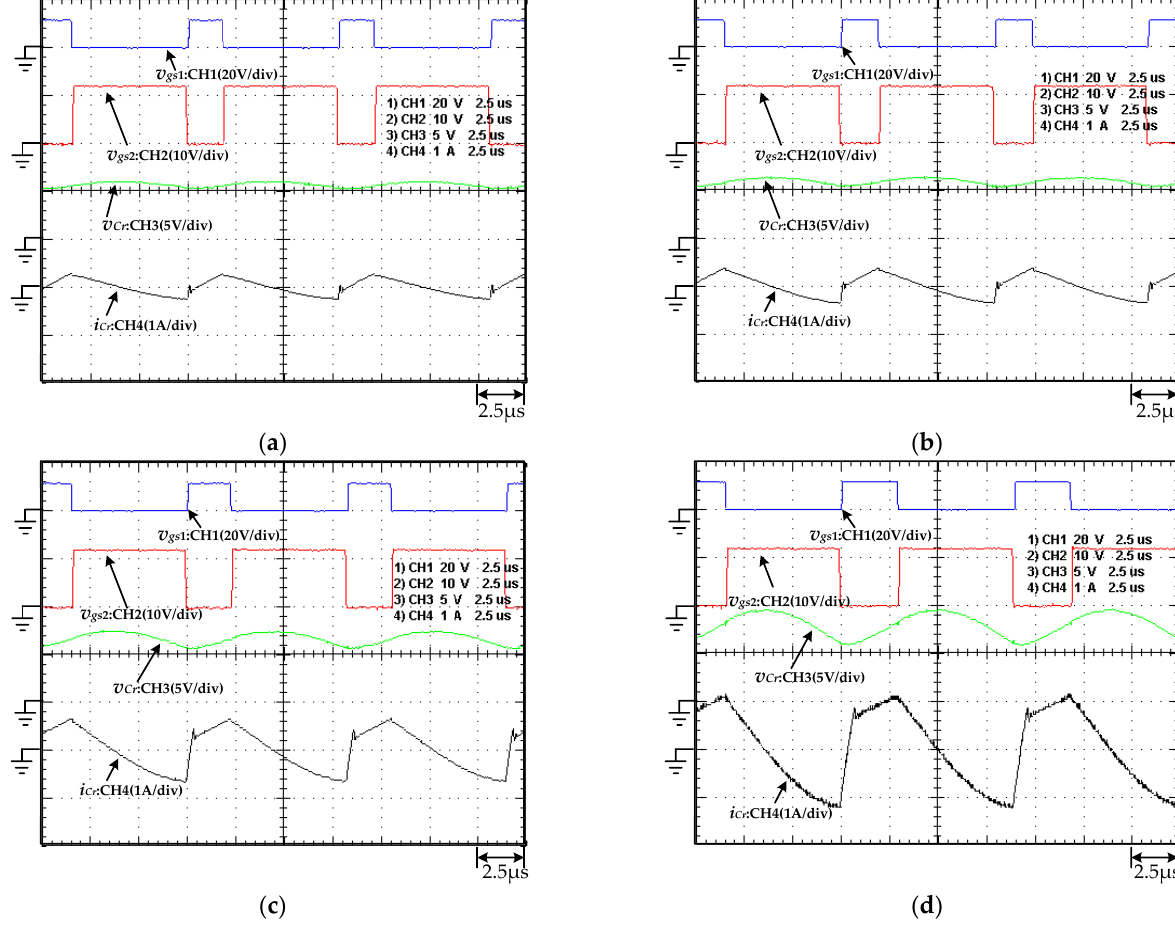
Figure 11. Measured waveforms of v gs 1 , v gs 2 , v Cr , and i Cr at input 24 V under ( a ) 10% load; ( b ) 20% load; ( c ) half load; and ( d ) full load.